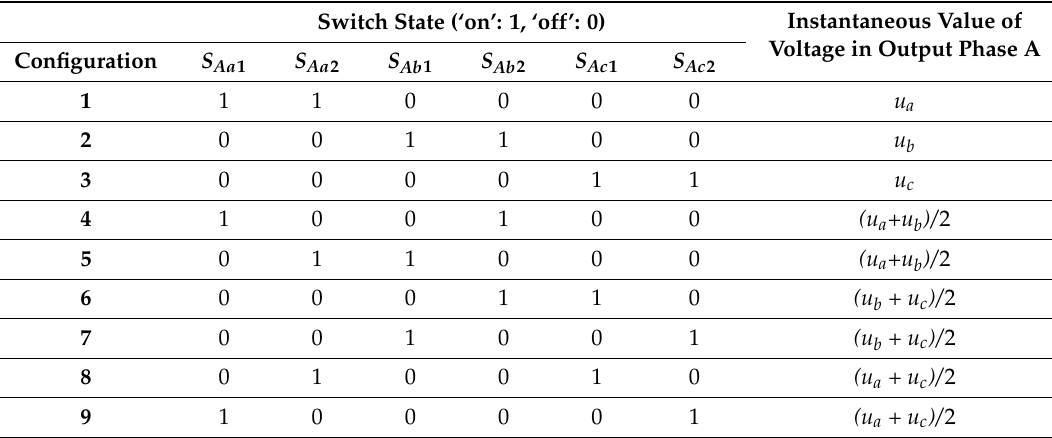
Table 1. Switch configuration of MMC in the output phase